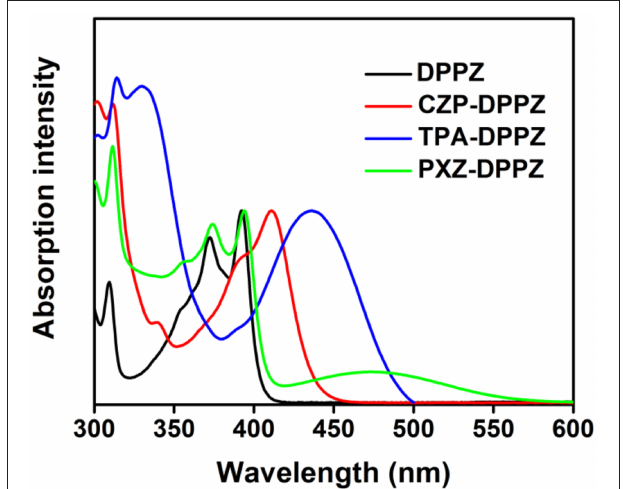
FIGURE 3 | The UV-vis spectra of DPPZ and three D-A structure molecules in THF solution (the concentration is 1 × 10 − 5 mol L − 1 ).